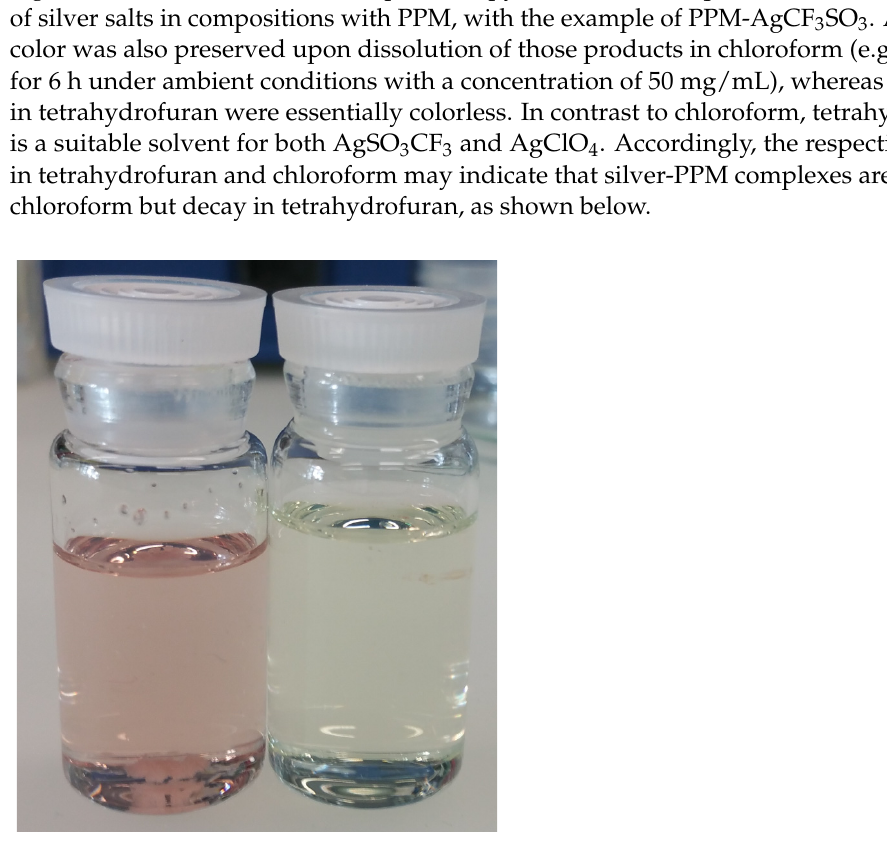
Figure 4. Typical color of a PPM-silver(I) solution (left vial) compared to the color of a PPM solution (right vial) in chloroform.